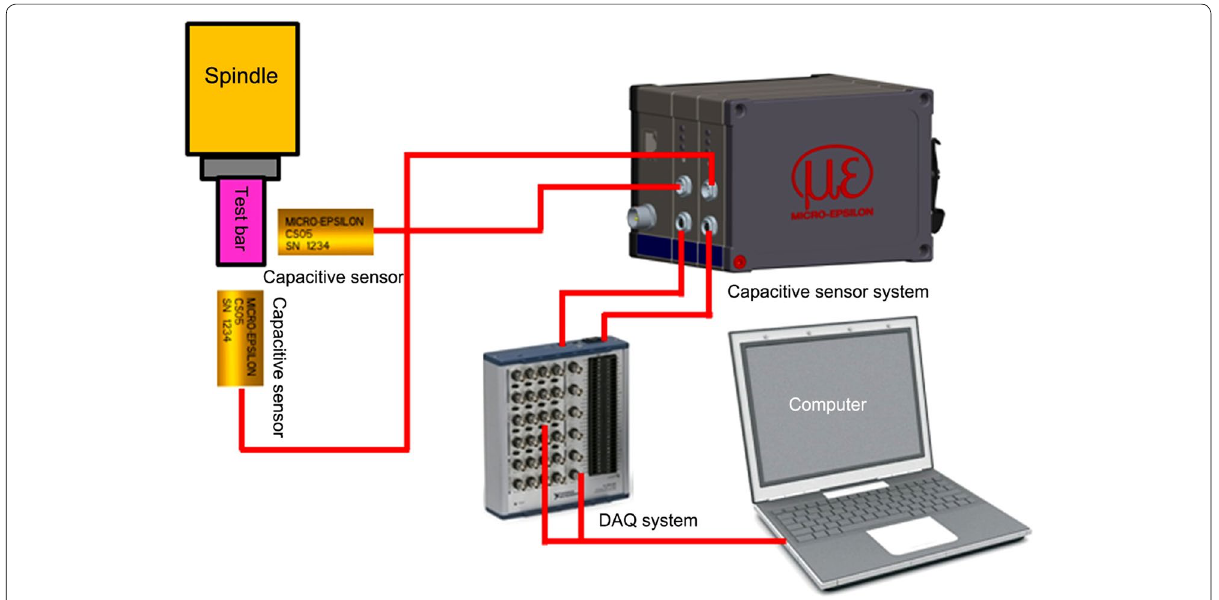
Figure 10 Schematic of the spindle runout test